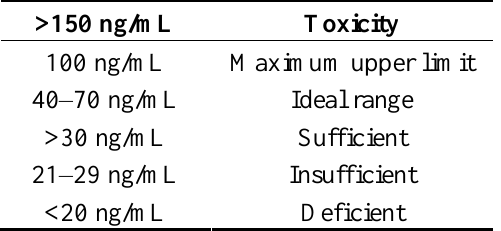
Table 1. Current accepted definitions of various Vitamin D levels include: